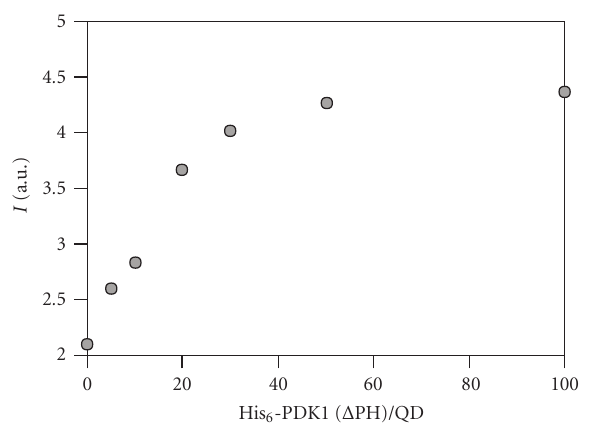
Figure 4: The supramolecular association of BODIPY-ATP with His 6 -PDK1( Δ PH)-QD encourages the transfer of energy from QD to BODIPY upon excitation (a). ATP displaces BODIPY-ATP from the recognition site of His 6 -PDK1( Δ PH)-QD and is ex- pected to prevent energy transfer (b). The nonspecific adsorption of BODIPY-ATP on the surface of QD, however, can also encour- age energy transfer (c). Under these conditions, the displacement of BODIPY-ATP by ATP is not su ffi cient to prevent energy transfer.